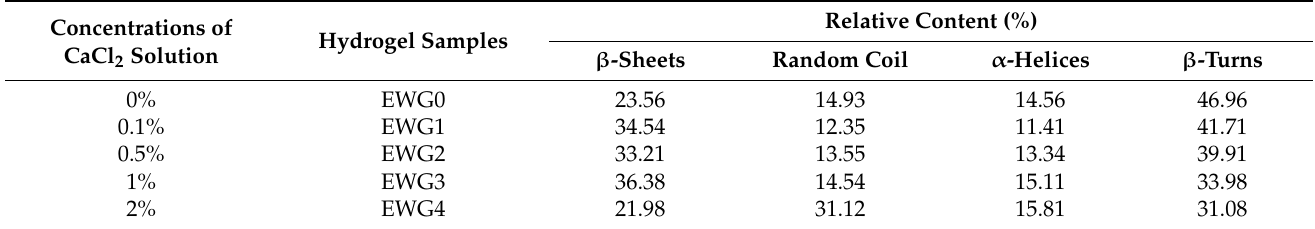
Table 1. Effect of CaCl 2 addition on the secondary structures of egg white protein.